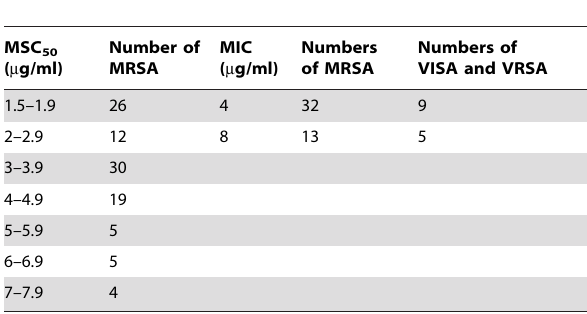
Table 1. The MSC 50 and MIC of HT61 against clinically isolated MRSA, VISA and VRSA.